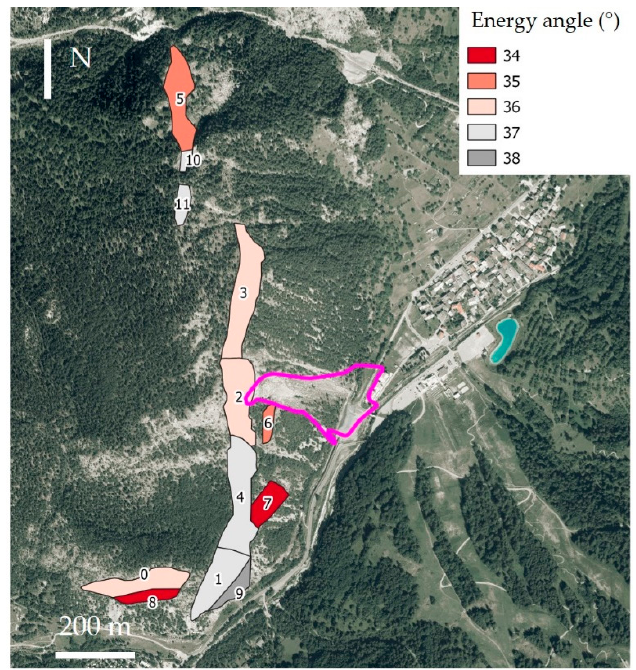
Figure 17. Homogeneous source areas with indication of the energy angle φ p associated to each one. Runout area of 2010 event in magenta. Orthophoto AGEA 2018.